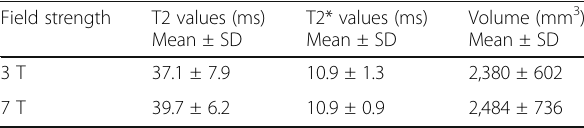
Table 3 Anterior cruciate ligament quantitative MRI at 3 T and 7 T Field